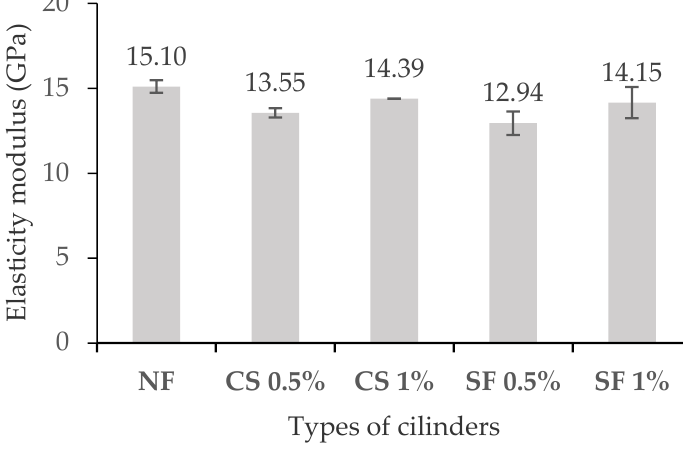
Figure 6. Modulus of elasticity for design strength of 20.59 MPa.